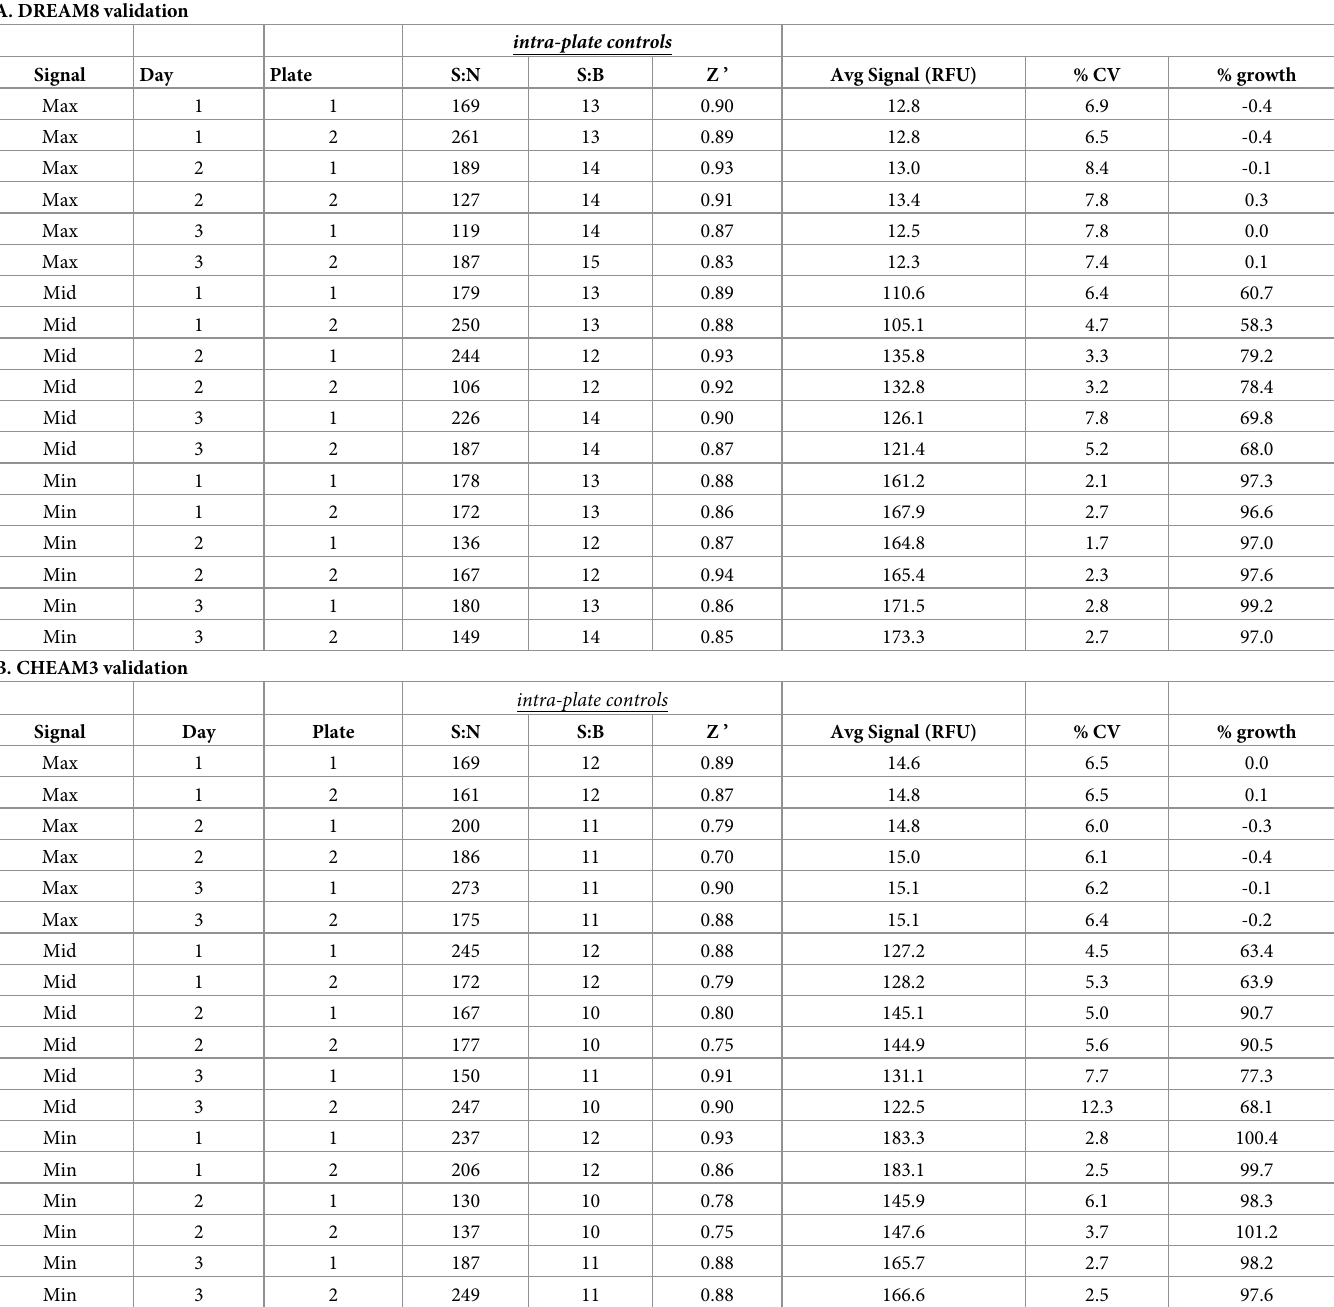
Table 2. High throughput screen validation